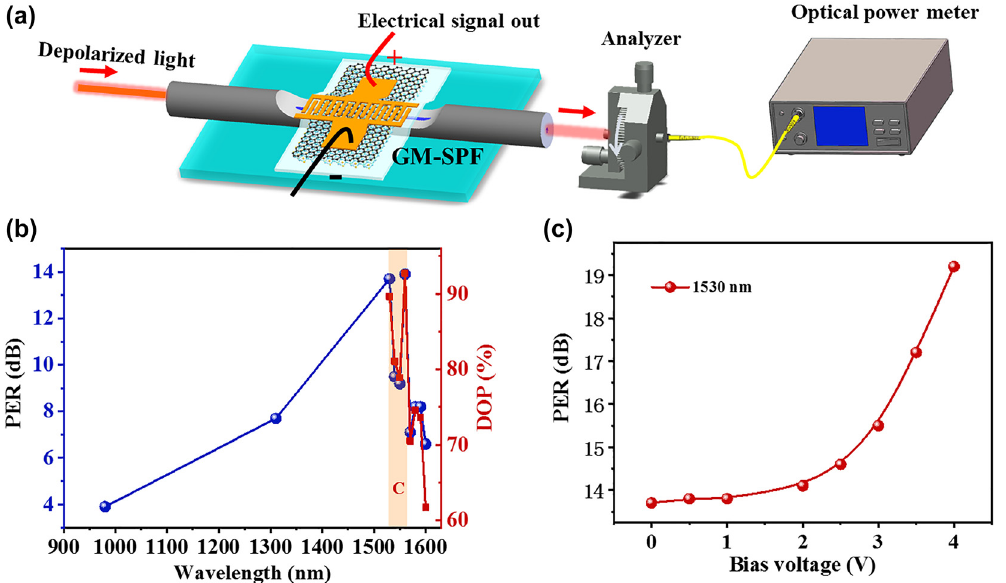
Figure 3: The polarization characteristics of PPID. (a) Schematic diagram of the experimental setup for measuring the polarizing effect of PPID; (b) the PER (blue line) and the DOP (red line) as a function of wavelength at room temperature; (c) the PER increase with the bias voltage from 13.7 to 19.2 dB at 1530